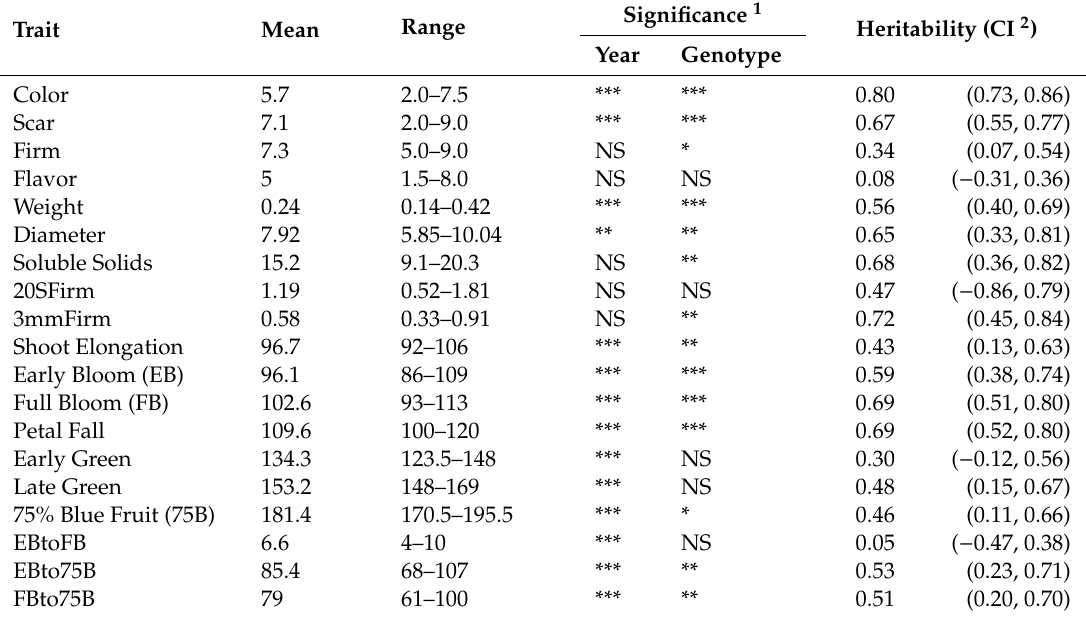
Table 1. This table summarizes the mean, range, and likelihood ratio test (LRT) results for year and genotype, and the heritability for each trait that was evaluated in the diploid blueberry